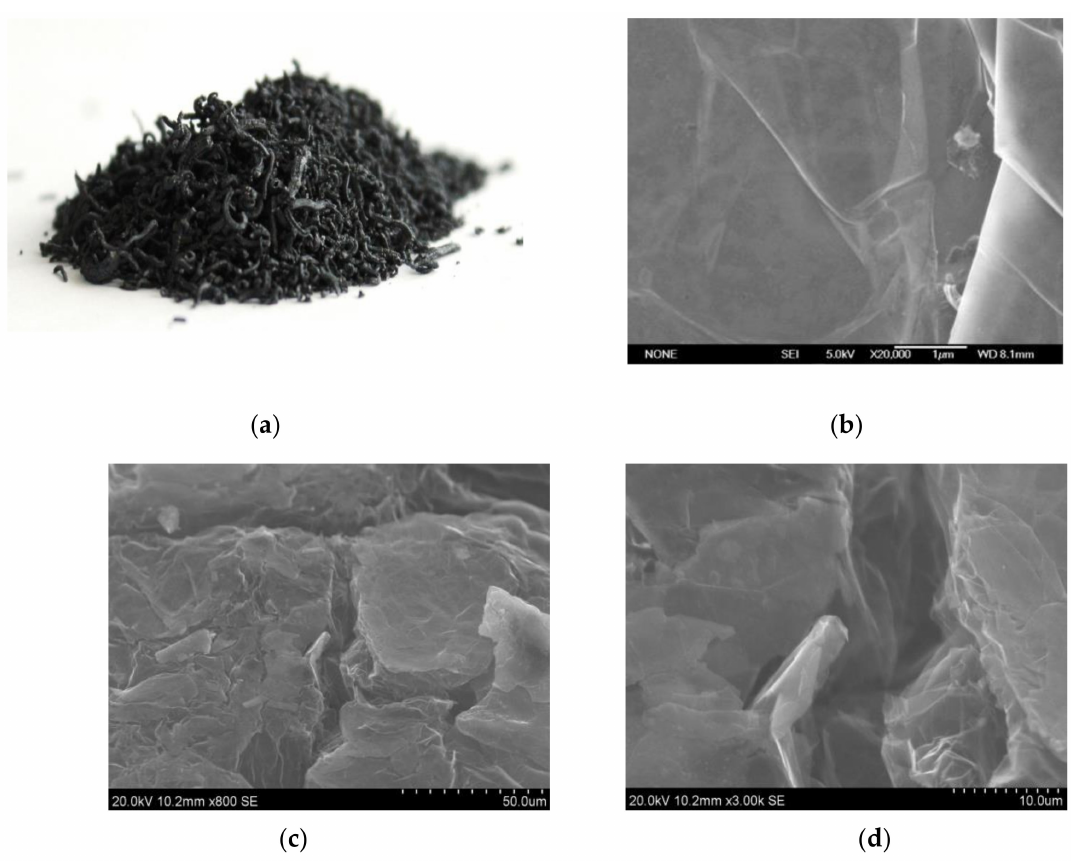
Figure 2. ( a ) Appearance of EG; ( b–d ) SEM images of EG.